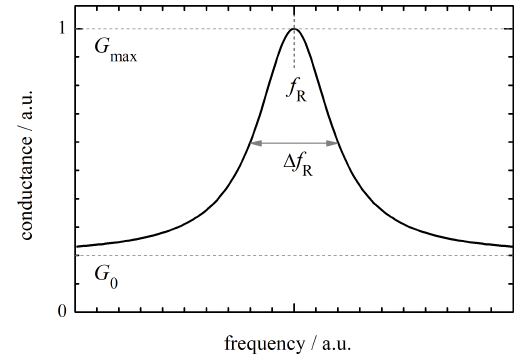
Figure 4. Conductance G of a resonator in the vicinity of the reso- nance frequency f R